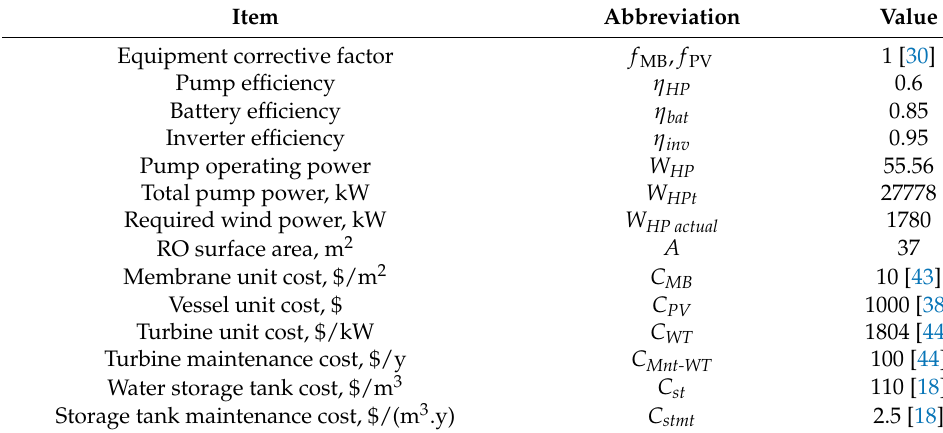
Table A3. Operating and Design